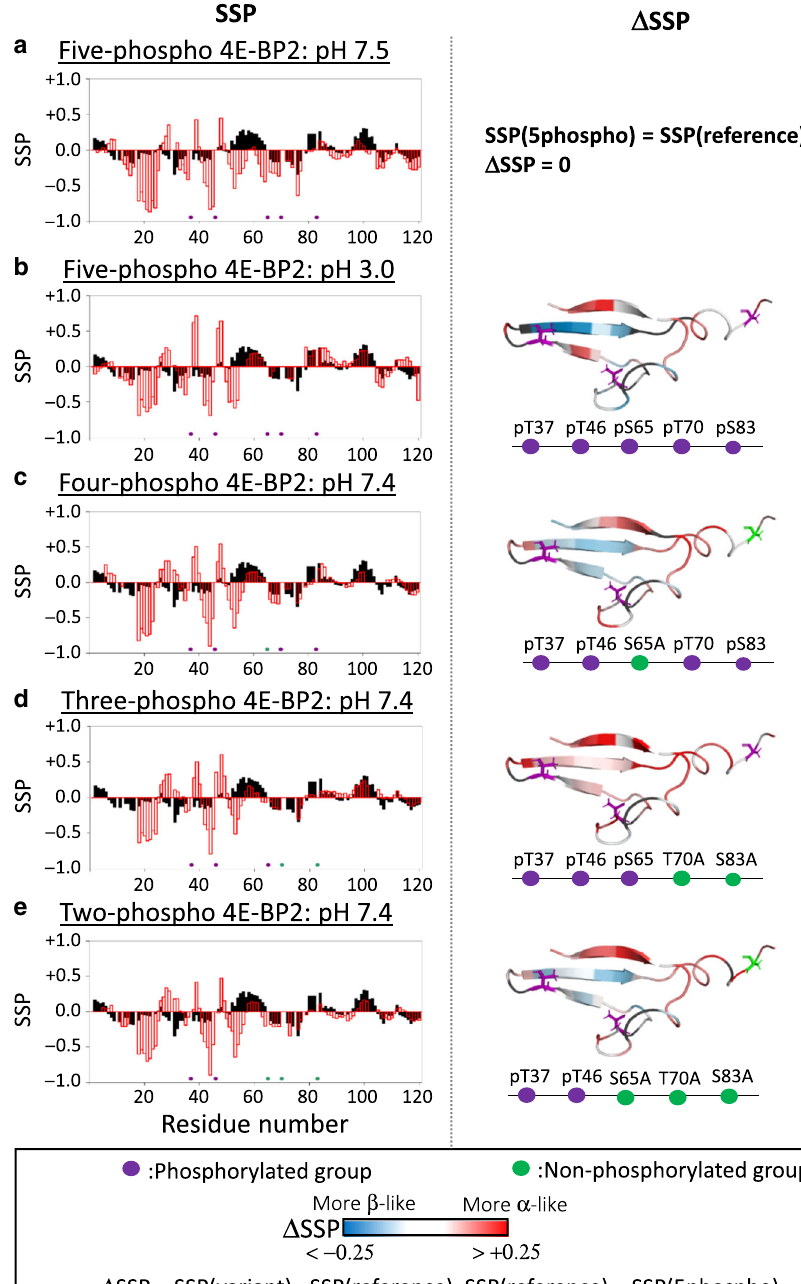
Fig. 4 Effects of the C-IDR phosphorylation on 4E-BP2 folded domain secondary structure. The secondary structural propensities (SSP) are sensitive to secondary structural elements and were derived from backbone and sidechain NMR chemical shifts. In the left column, SSP values are plotted versus residue number, where positive values indicate α -helical propensity and negative values indicate β -strand character. In each case, the black bars correspond to np-4E- BP2 SSP at pH 6.0 8 . The red bars are the SSP values for the phospho 4E-BP2 constructs being compared. The locations of the fi ve phospho-sites and the alanine mutations are shown as purple and green stick diagrams, respectively, on the structures and as colored circles on schematics. In the right column, the change in secondary structural propensities ( Δ SSP) values due to differences in pH or phosphorylation state were mapped onto the 4E-BP2 structure with increased α - helical propensity in red and increased β -strand character in blue. In each case, the changes are in reference to pH 7.5 5p-4E-BP2 values (making the Δ SSP values for 5p-4E-BP2 at pH 7.5 zero). a pH 7.5 5p-4E-BP2 SSP values. b pH 3.0 5p-4E-BP2. c 2p-4E-BP2 at pH 7.4. d 3p- (pT37/pT46/pS65) 4E-BP2 at pH 7.4 (as in Fig. 3c). e 4p- (pT37/pT46/pT70/pS83) 4E-BP2 at pH 7.4 (as in Fig. 3e). Source data are provided as a Source Data fi